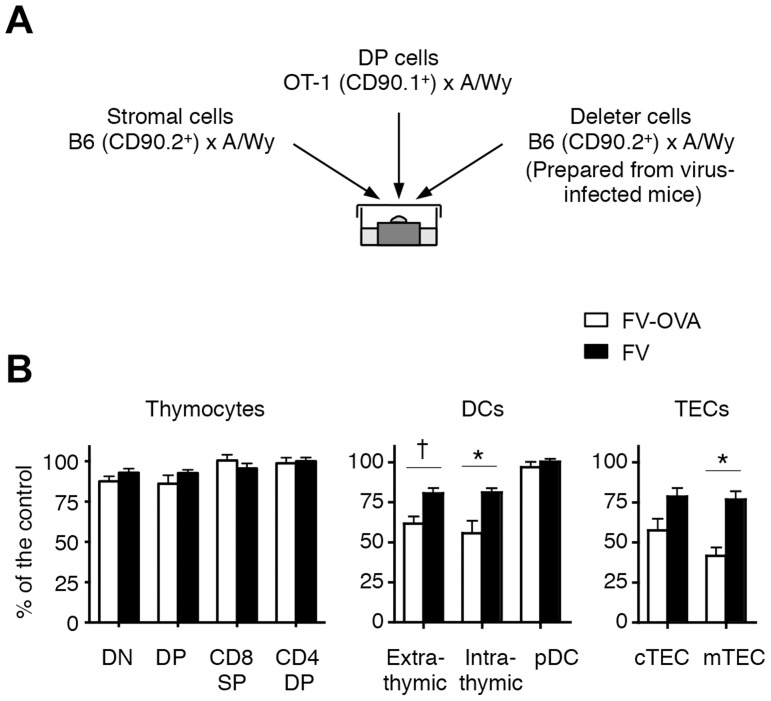
Thymic DCs and TECs are the major deleters of FV-specific thymocytes.(A) Thymic stromal cells of B6AF1 mice were prepared from E15.5 fetal thymus lobes. OT-1 DP thymocytes were sorted from adult (OT-1-Thy1.1× A/WySnJ)F1 mice. Thymocytes, thymic DCs and TECs from FV-OVA infected mice (21 days post infection) were sorted into each population as indicated in Figure 2. Cells were mixed and cultured as a reassembled organ for 4 days. (B) Shown are relative percentages of CD8 SP cells as compared to the control. The percentage of the control value was calculated by [(% of CD8 SP cells in the experimental culture)/(% of CD8 SP cells in the control culture)]×100 (see Figure S5). Averages were compared between FV-OVA- and FV-infected groups for each third cell population by two-way ANOVA with Bonferroni's correction for multiple comparisons, and statistically significant differentiations are indicated: *, p<0.01; †, p<0.05.